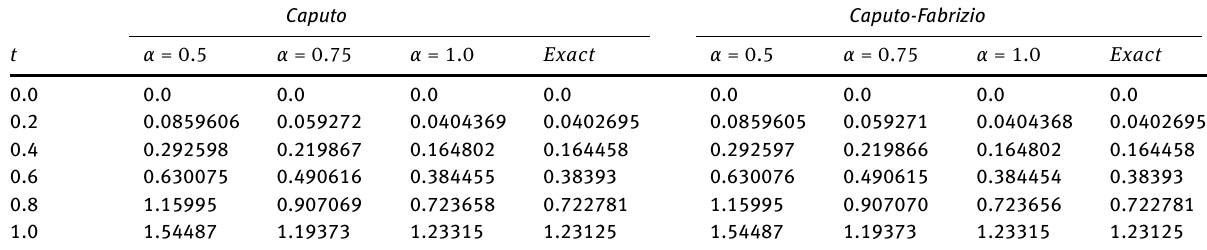
Table 3: The exact and approximate result of test example 5.2 featuring various values of α , with Caputo and Caputo-Fabrizio derivative. Caputo Caputo-Fabrizio